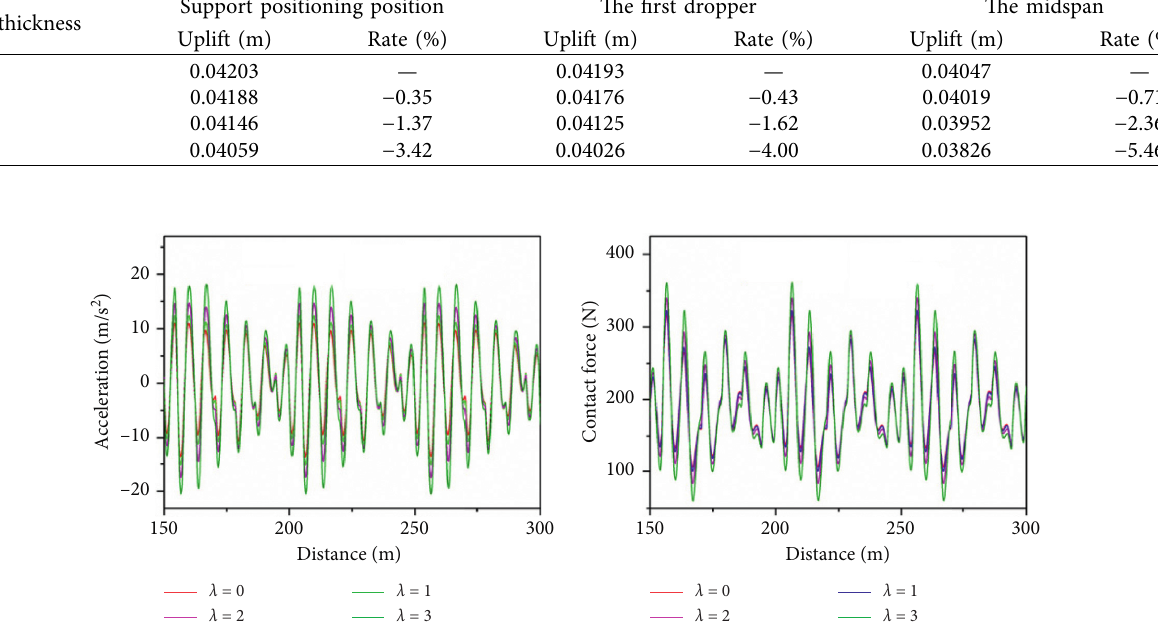
Figure 11: Dynamic characteristics between pantograph and catenary (combinatorial material method). (a) Acceleration. (b) Contact